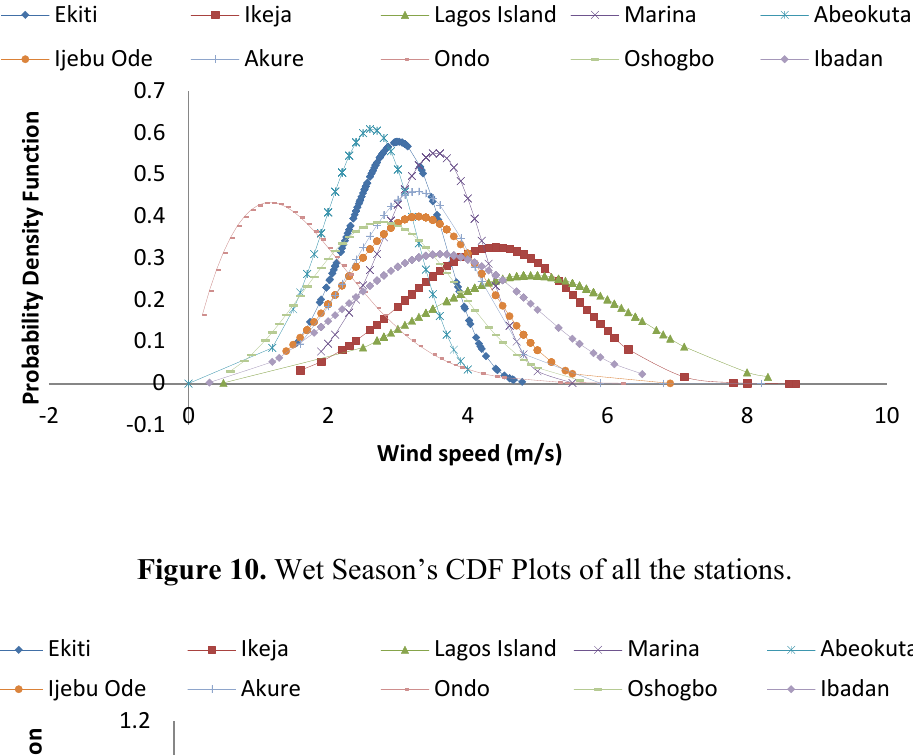
Figure 9. Dry Season’s PDF Plots of all the stations.